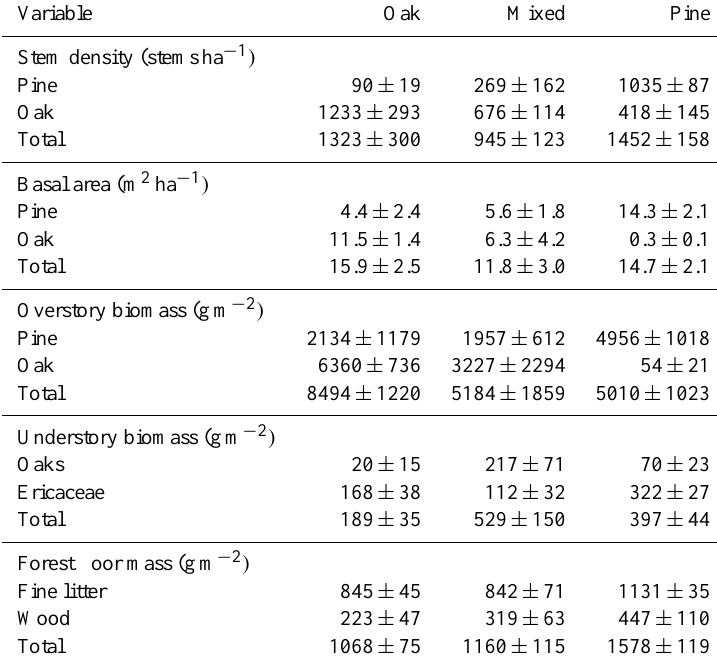
Table 1. Forest structure at the oak, mixed, and pine stands at the beginning of the study in 2005. Overstory data are from five 201m 2 plots measured in 2005, understory biomass is from 10 to 20 1.0m 2 clip plots, and forest floor mass (Oi layer) is from ten 1.0m 2 plots in the vicinity of the tower at each site. Values are means ± 1 standard